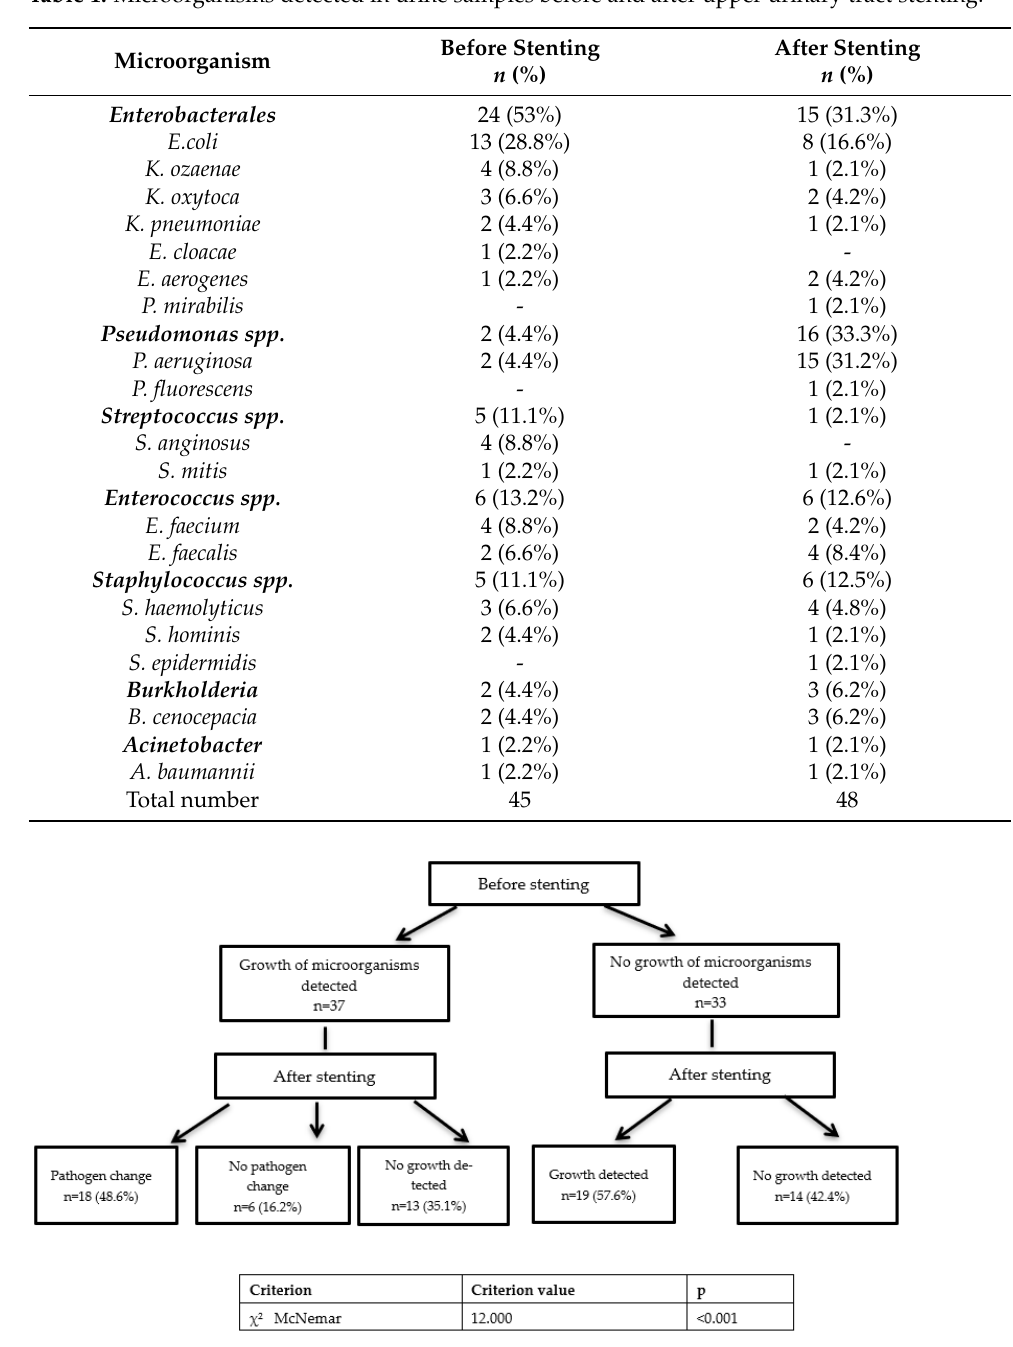
Figure 1. Changes in microflora after the upper urinary tract stenting. The following changes in the number of strains were revealed for the individual microorganisms: E. coli was detected in 13 patients (18.6%) before stenting; however, after stenting, this pathogen was no longer observed in 12 of these patients (17.1%). The decrease in the frequency of E. coli detection was statistically significant ( p = 0.015). S. anginosus was detected in four patients (5.7%) before stenting, while after stenting, this pathogen was completely absent in these patients. The decrease in the frequency of detection of S. anginosus is also statistically significant ( p =